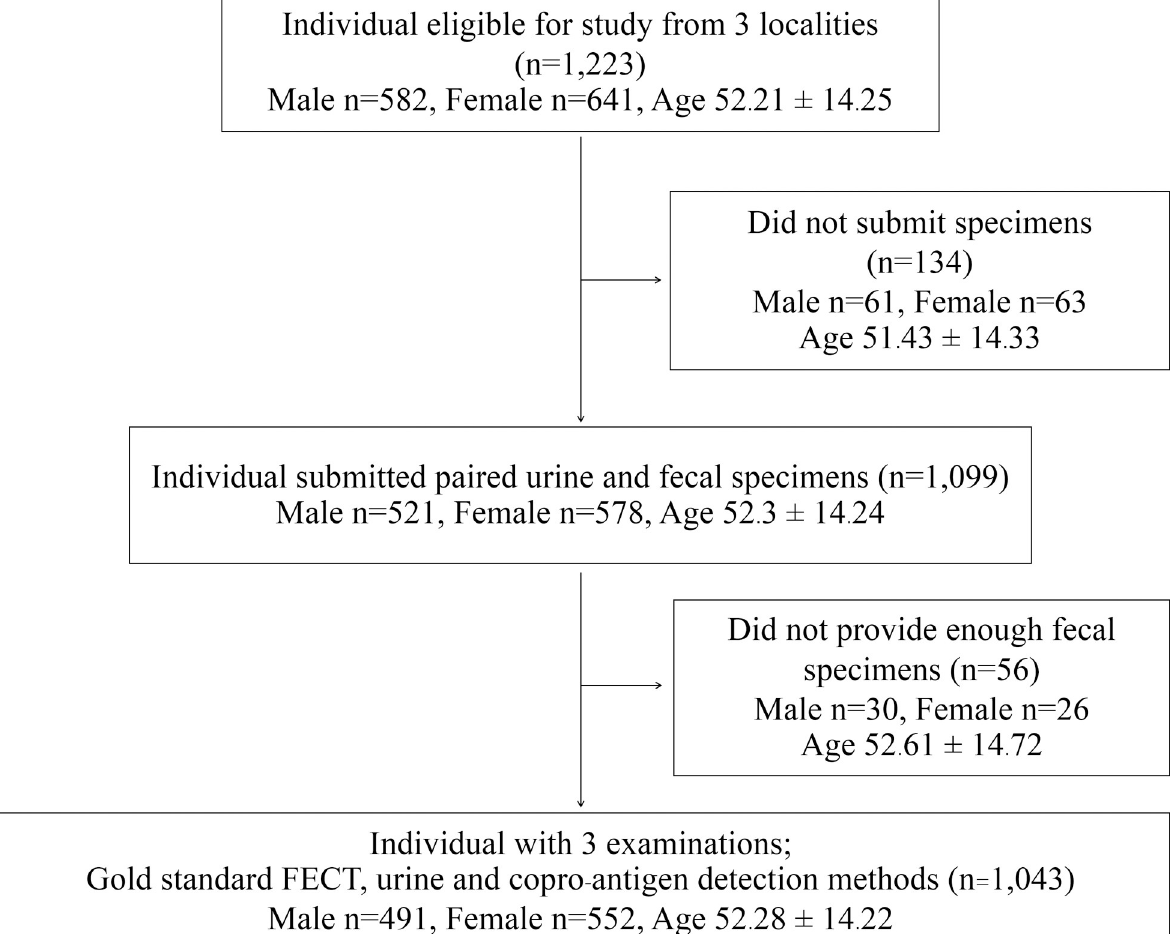
Fig 1. Flow diagram of study participants and sample collection. The flowchart shows the number of participants included and excluded from the project comparing diagnostic methods for human opisthorchiasis by formalin ethyl-acetate concentration technique (FECT) and antigen detections in urine and fecal